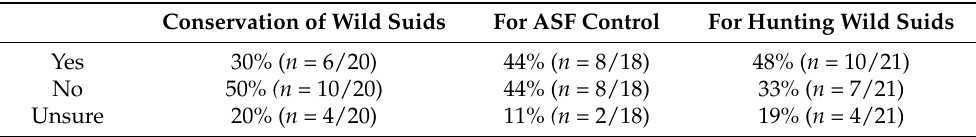
Table 8. The proportion of Members implementing regulations or legislation for conservation, African Swine Fever (ASF) control and hunting of wild